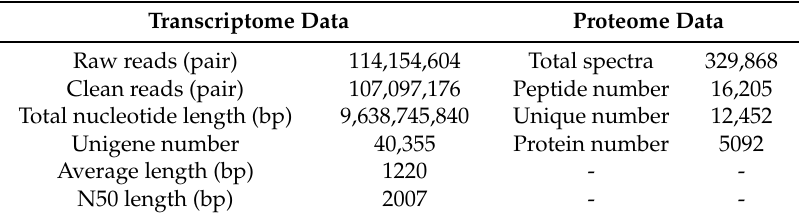
Table 1. Transcriptome and proteome data in Bursaphelenchus mucronatus ( B. mucronatus